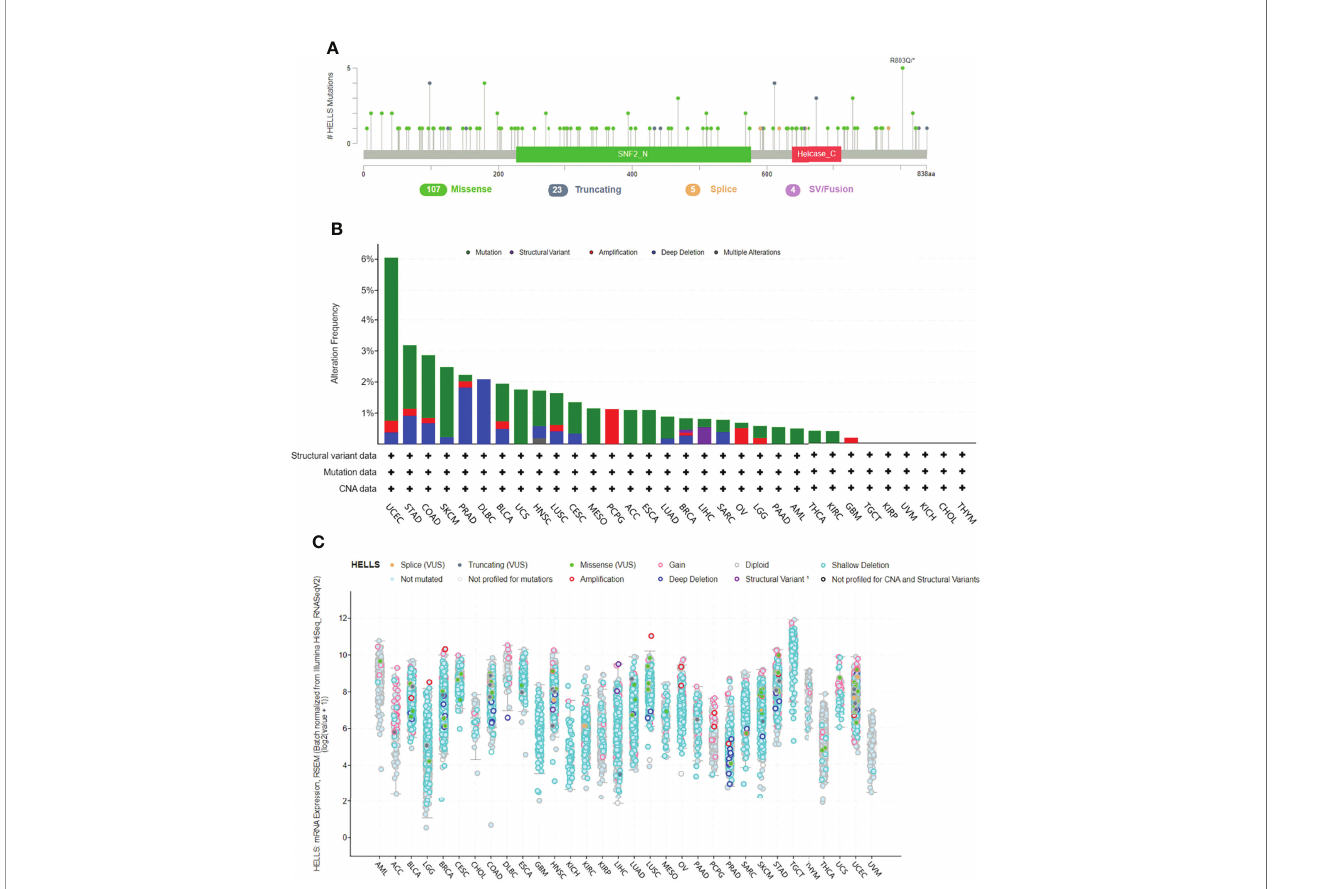
FIGURE 8 | Genetic alteration of HELLS in 32 cancers. (A) Mutation diagram of HELLS across protein domains; (B) Bar chart of HELLS mutations in 32 cancer studies based on TCGA PanCancer Atlas Studies; (C) Mutation counts and types of HELLS in 32